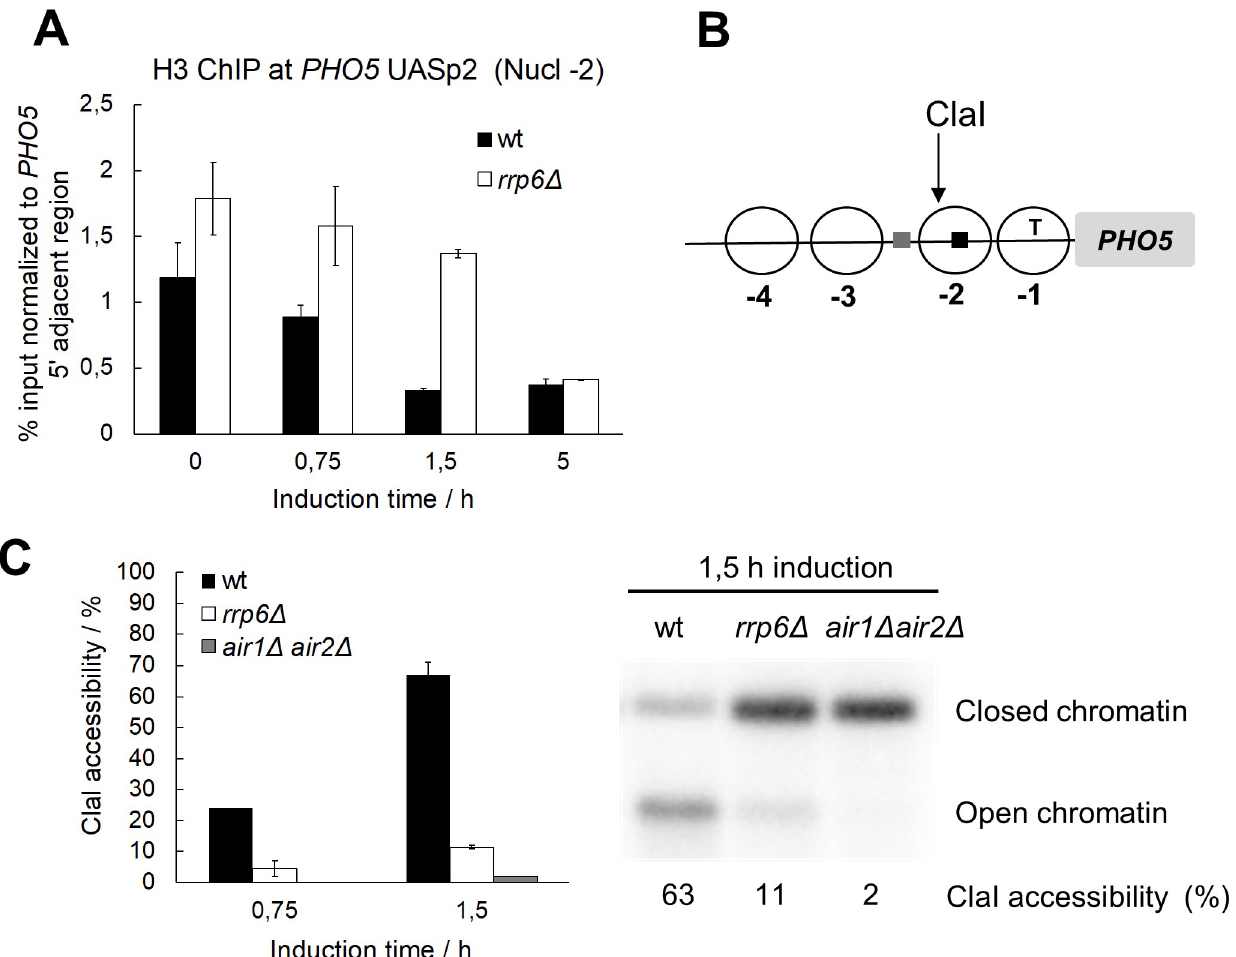
Fig 6. PHO5 AS elongation negatively affects kinetics of histone removal at the PHO5 gene promoter upon induction. (A) ChIP analysis of histone H3 binding at nucleosome -2 of the PHO5 gene promoter in wild-type BMA41 (wt) and corresponding rrp6 Δ cells upon induction through phosphate starvation. Immunoprecipitated DNA was quantified by qPCR and normalized to a control genomic region adjacent to the PHO5 gene locus. (B) Scheme of the PHO5 gene promoter region. Nucleosomes are denoted by circles, Pho4 binding sites by squares (gray—low affinity, black—high affinity) and the TATA box by the letter T. Site of cleavage with the ClaI restriction enzyme is denoted by a black arrow. (C) Kinetics of PHO5 promoter opening monitored by ClaI accessibility at nucleosome -2 after induction as in